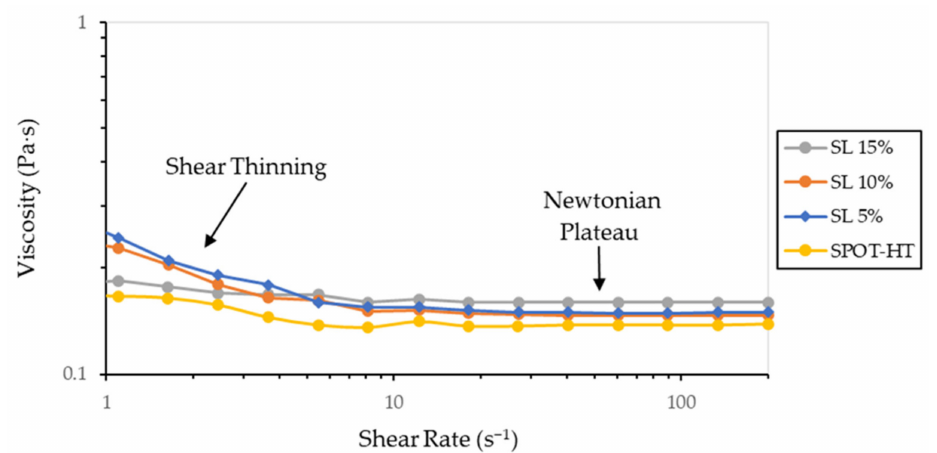
Figure 6. Comparison between selected viscosity curves of reinforced suspensions and base resin. Given the low viscosity of the material, it presents a first irregular shear thinning zone that varies slightly between measurements at low shear rates, but which stabilizes and always presents the same viscosity at high shear rates.